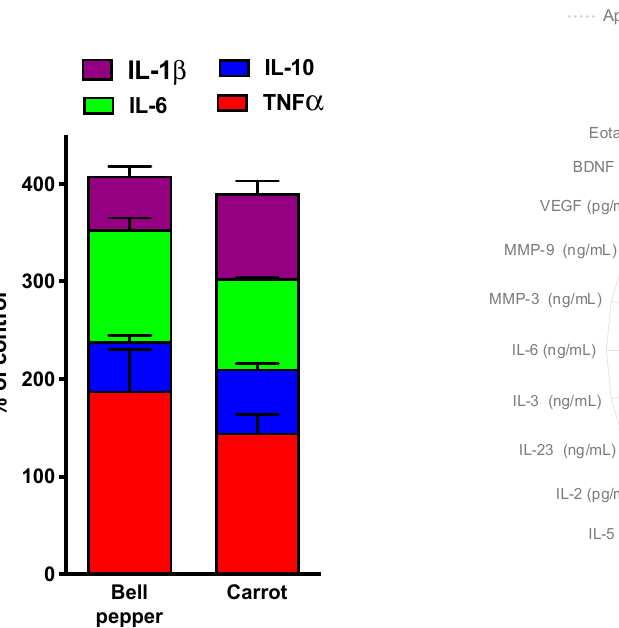
Figure 4. Left: bpRG-I and cRG-I (300 µg/mL) induced comparable cytokine secretion profiles in PBMCs. Average from three healthy donors normalized to LPS standard in those donors. Right: Secretome profiles in whole blood induced by 500 µg/mL bpRG-I (red) and cRG-I (orange), apple pectin (mainly HG, dotted), β -glucan (dashed), and positive control (LPS + SAB; dash, dot dot). Values below 0.01 pg or ng/mL are projected at 0.01 to enable graphic representation.